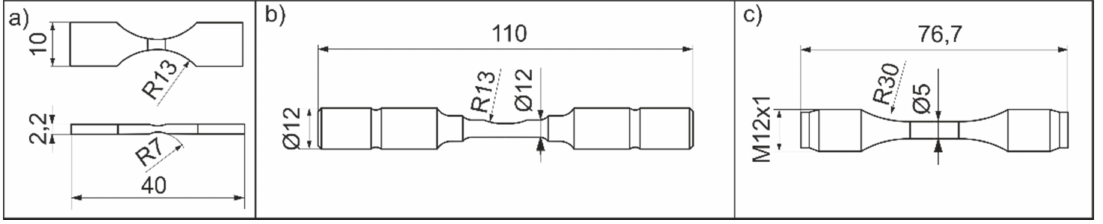
Figure 3. Specimen geometry ( a ) in situ specimen with two shallow notches, Siegen; ( b ) servohydraulic specimen with single shallow notch, Siegen; ( c ) servohydraulic specimen, Stuttgart.